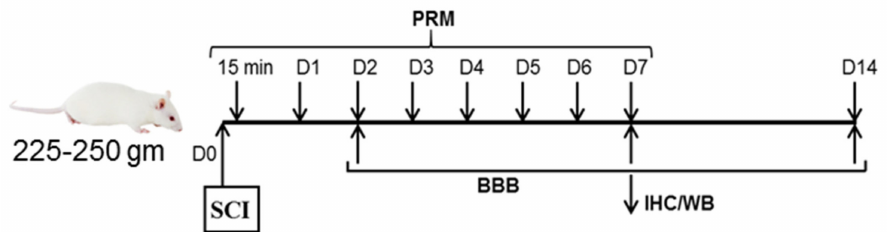
Figure 1. The flow chart indicates experimental overview. A 1 cm section of spinal cord centered on the lesion as well as 1 cm rostral (starting 0.5 cm rostral from the impact epicenter) and 1 cm caudal (starting 0.5 cm caudal from the impact epicenter) were collected for all groups so that the location and size remained the same for quantitative analysis. This study tested longitudinal lesion sections (1/2 + 1/2) by both immunohistochemistry and western blotting. All analyses were performed in a blinded fashion using standardized protocols